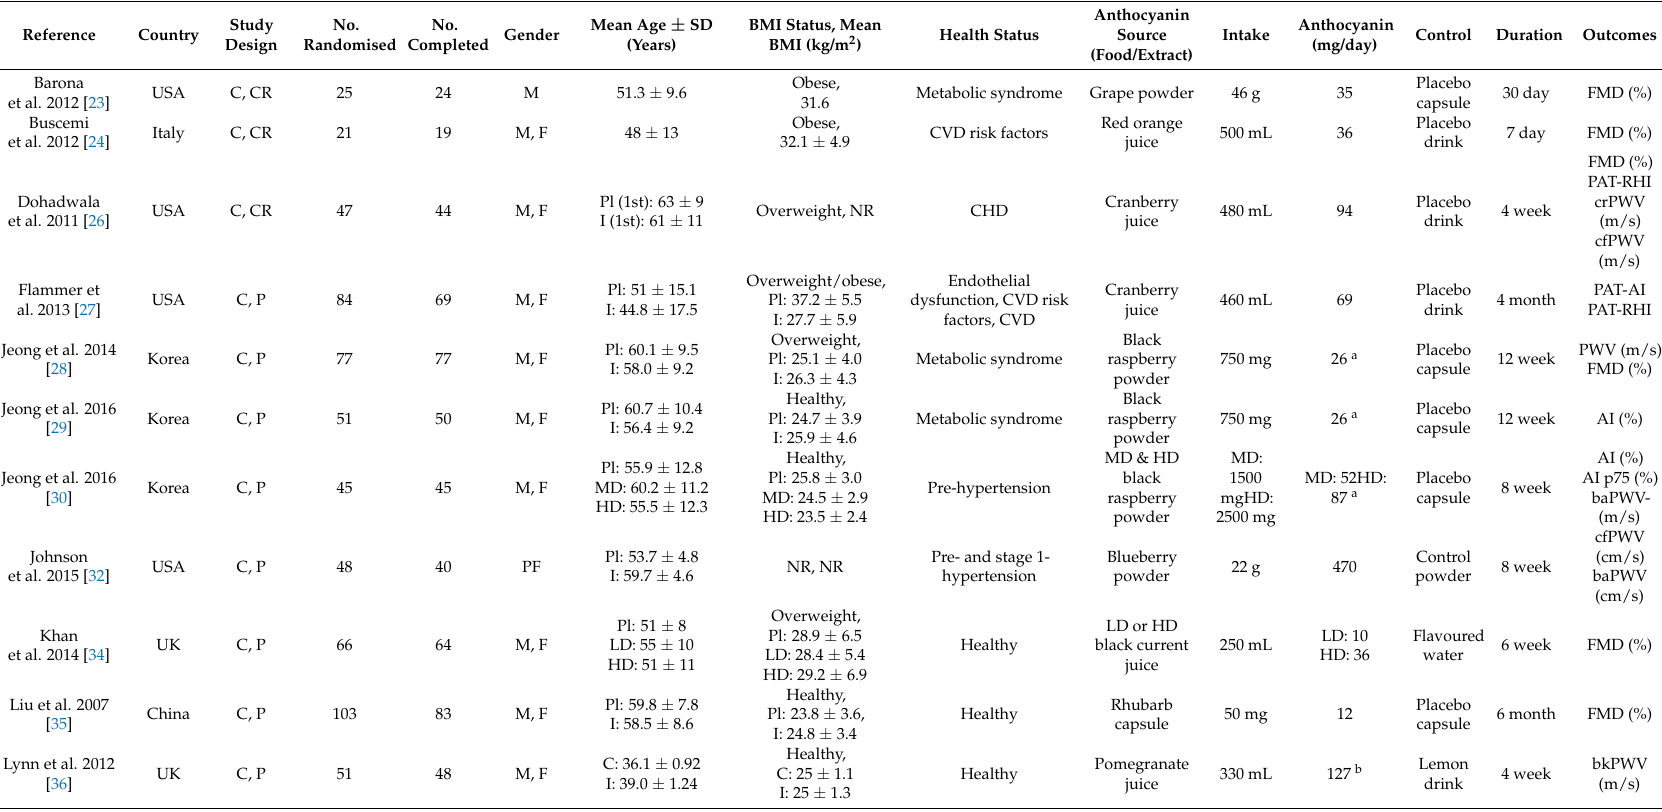
Table 3. Chronic study